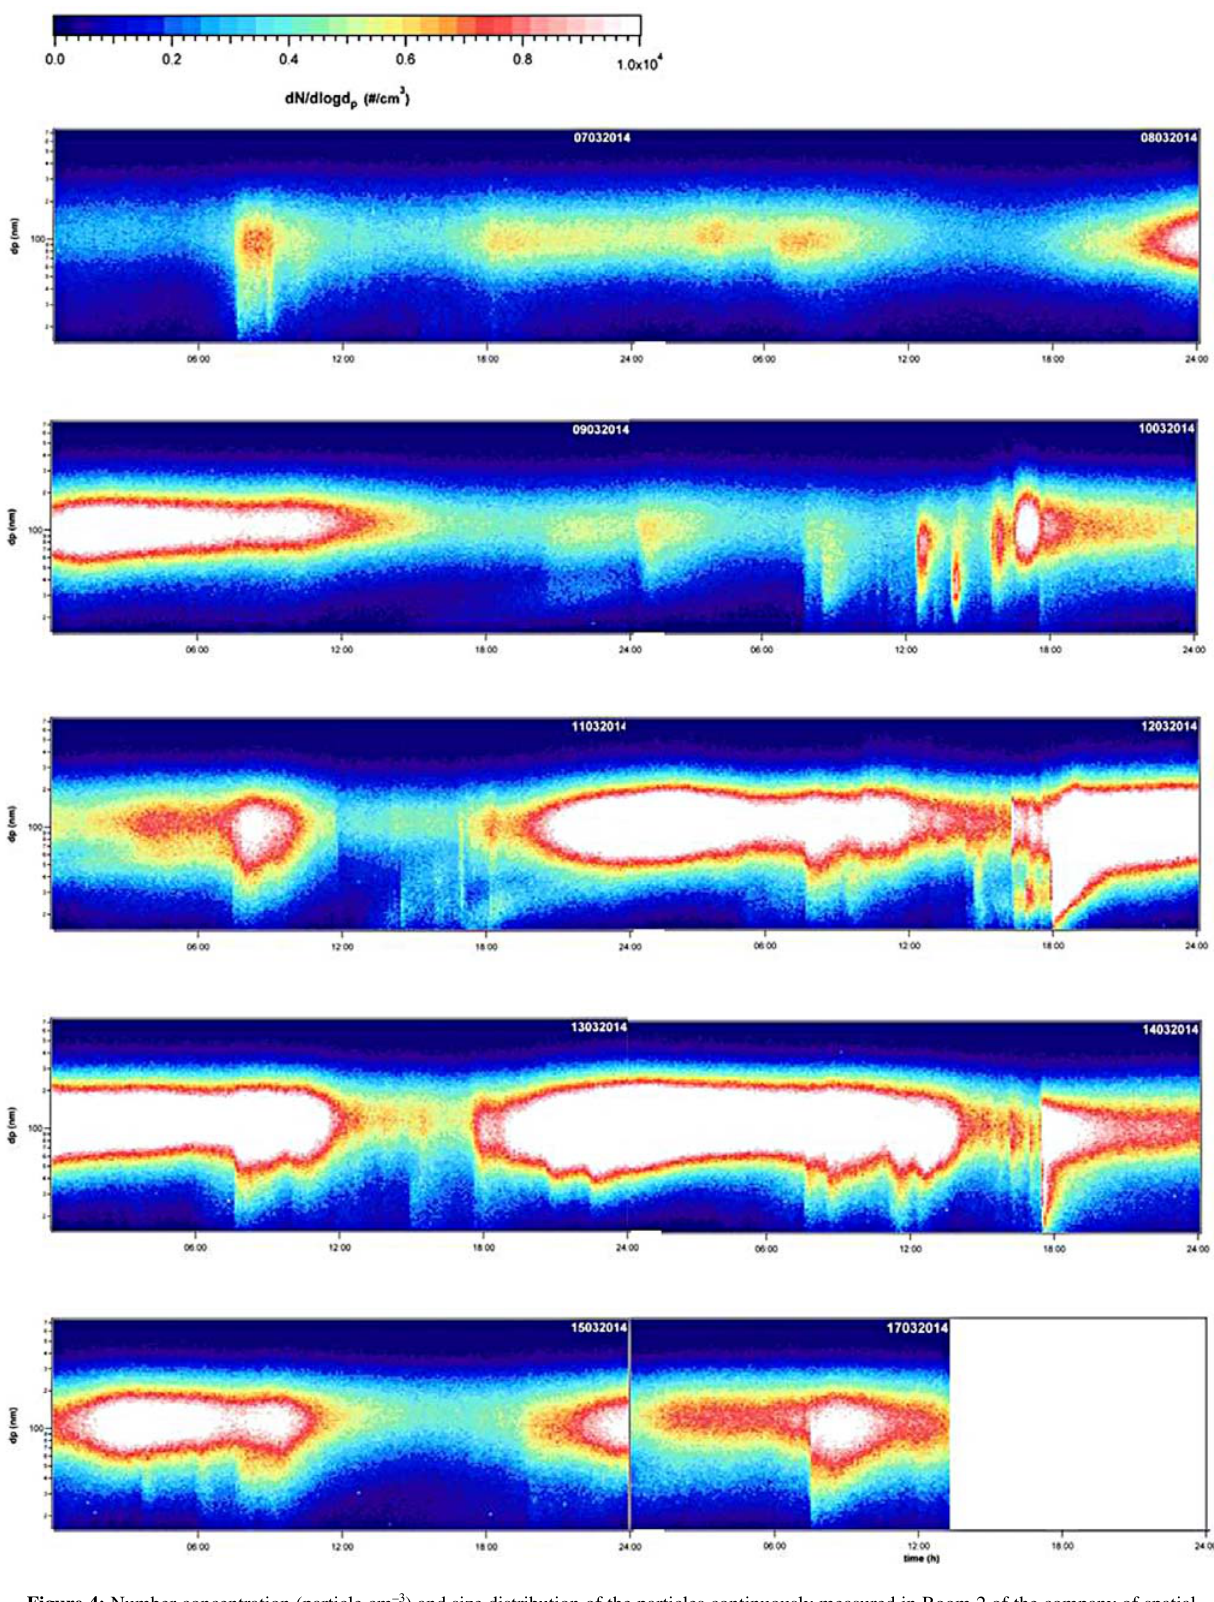
Figure 4: Number concentration (particle cm –3 ) and size distribution of the particles continuously measured in Room 2 of the company of spatial informatics and graphic design in Ljubljana, Slovenia from March 7 to March 17, 2014. White color represents the concentrations above 10 × 10 3 particle cm –3